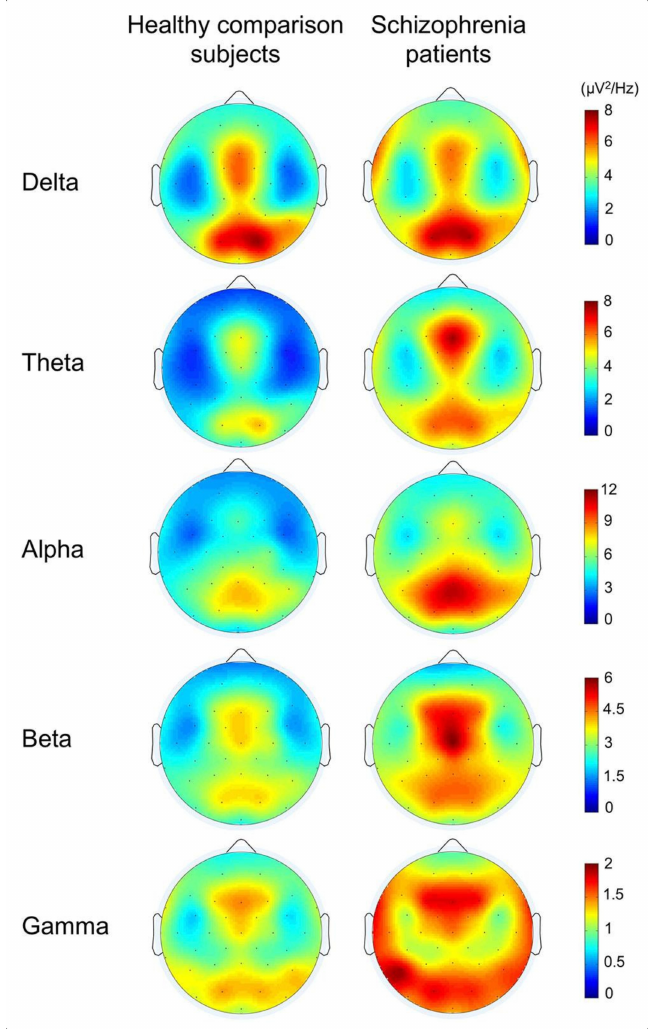
Figure 9. The topographies for grand average spectral power in schizophrenia patients and healthy comparison subjects (reproduced with permission from